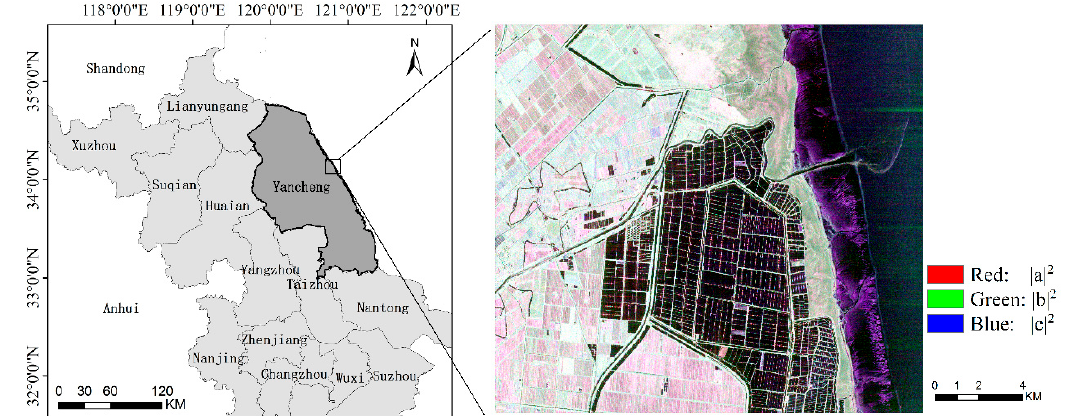
Figure 1. Location and Pauli RGB image acquired on 22 September 2017 by GF-3 of the study site. |a| 2 , |b| 2 and |c| 2 are the three components of Pauli decomposition.